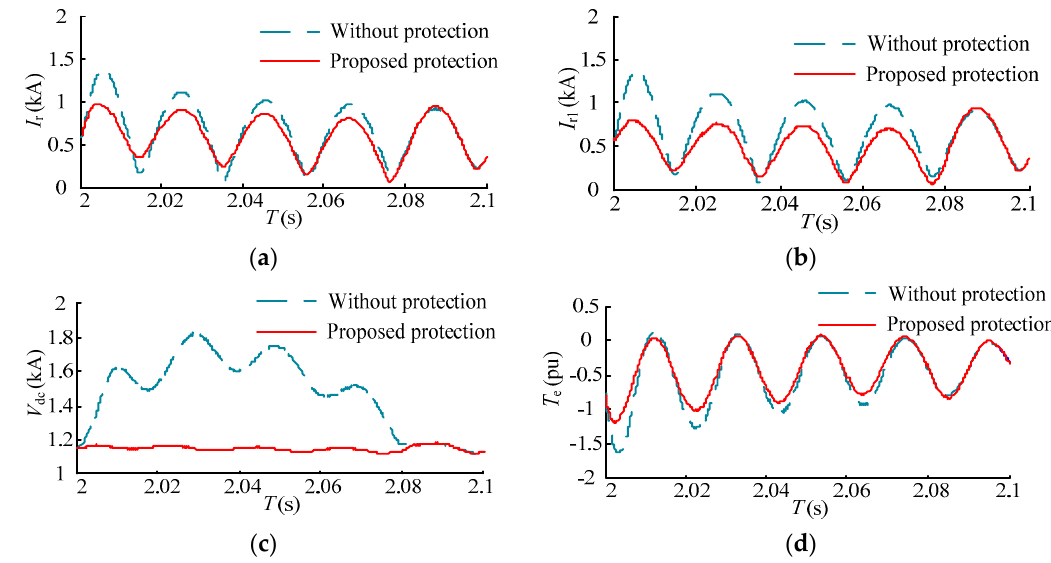
Figure 14. Response of proposed protection under a voltage sag of 0.6. ( a ) Rotor current; ( b ) RSC current; ( c ) DC-link bus voltage; and ( d ) electromagnetic torque.